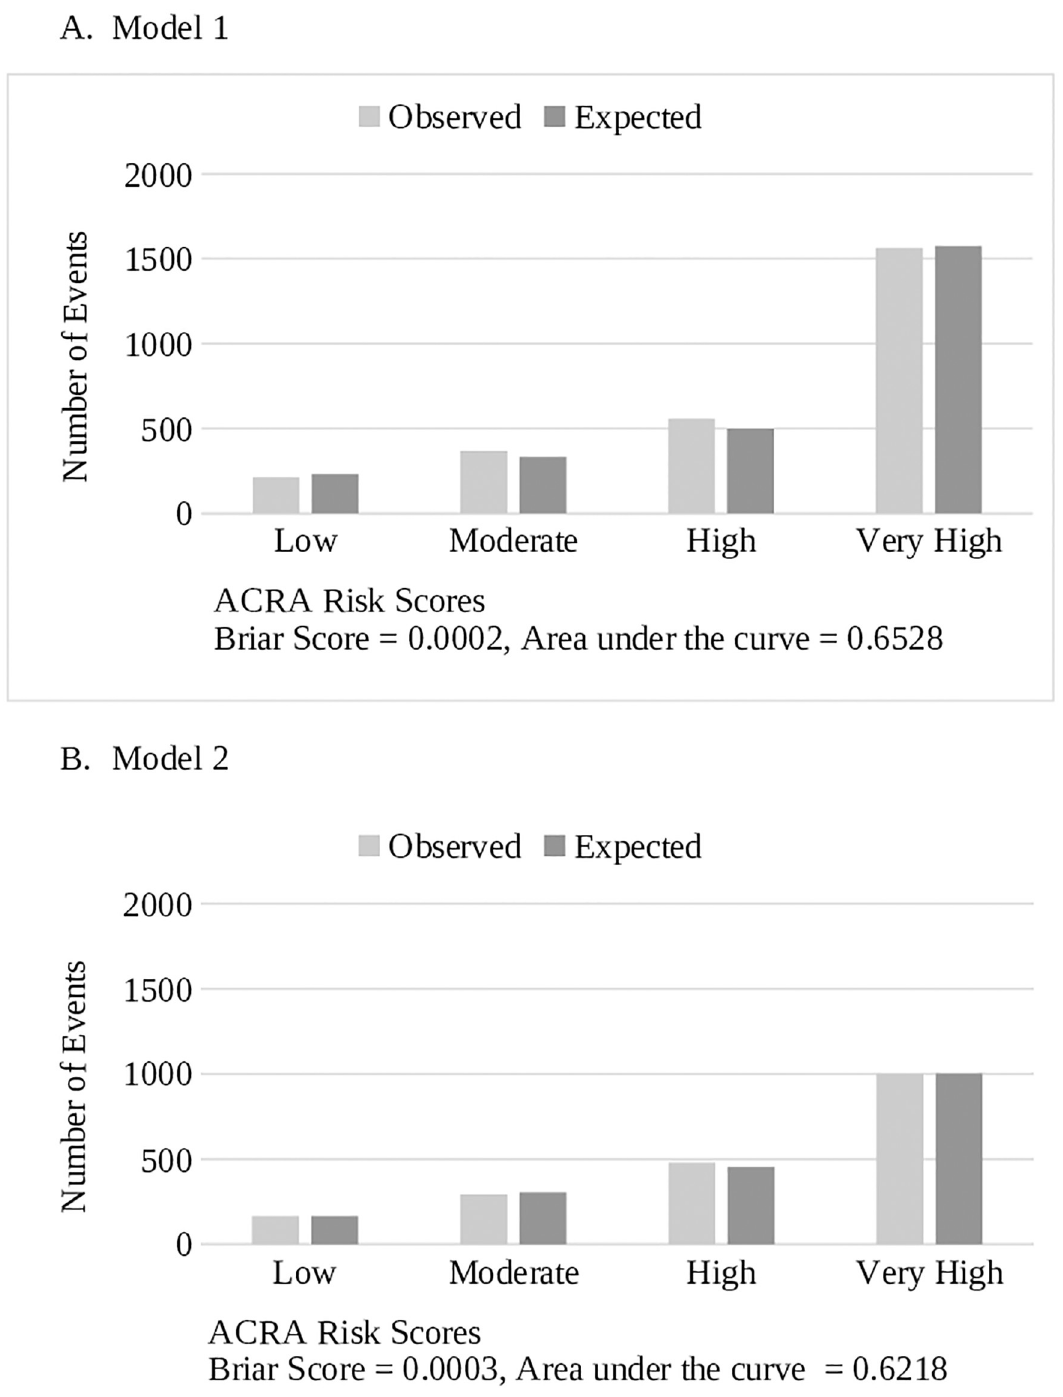
Fig 1. Comparison of predicted and observed cardiac events from ACRA